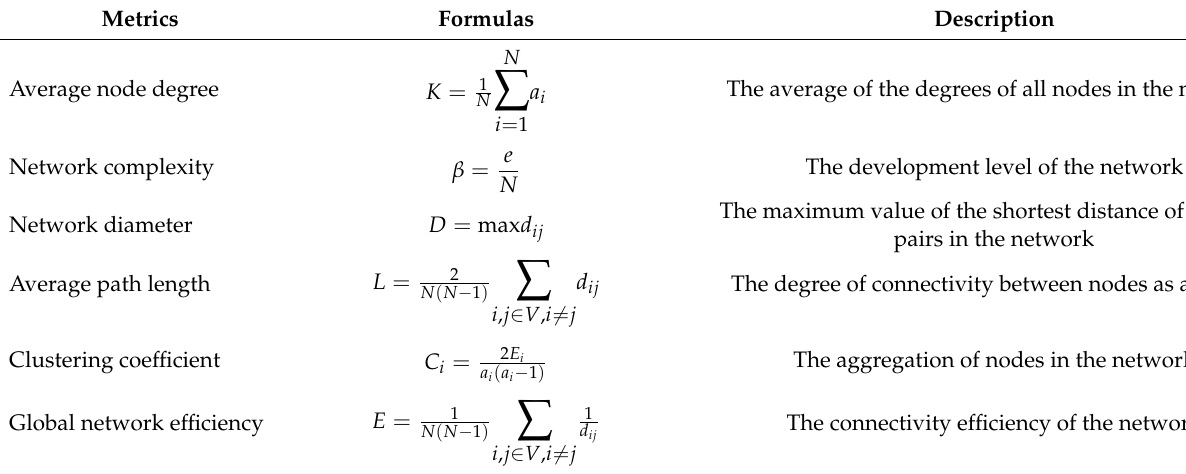
Table 3. The complexity network